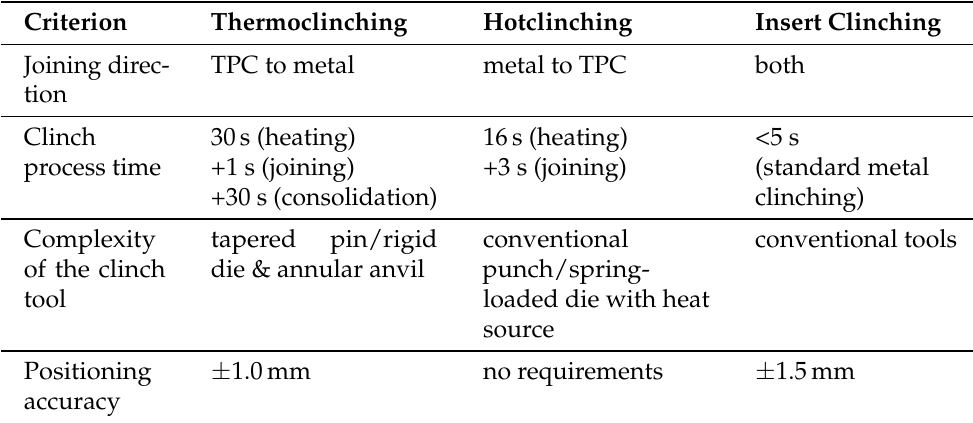
Table 4. Comparison of the three clinching technologies’